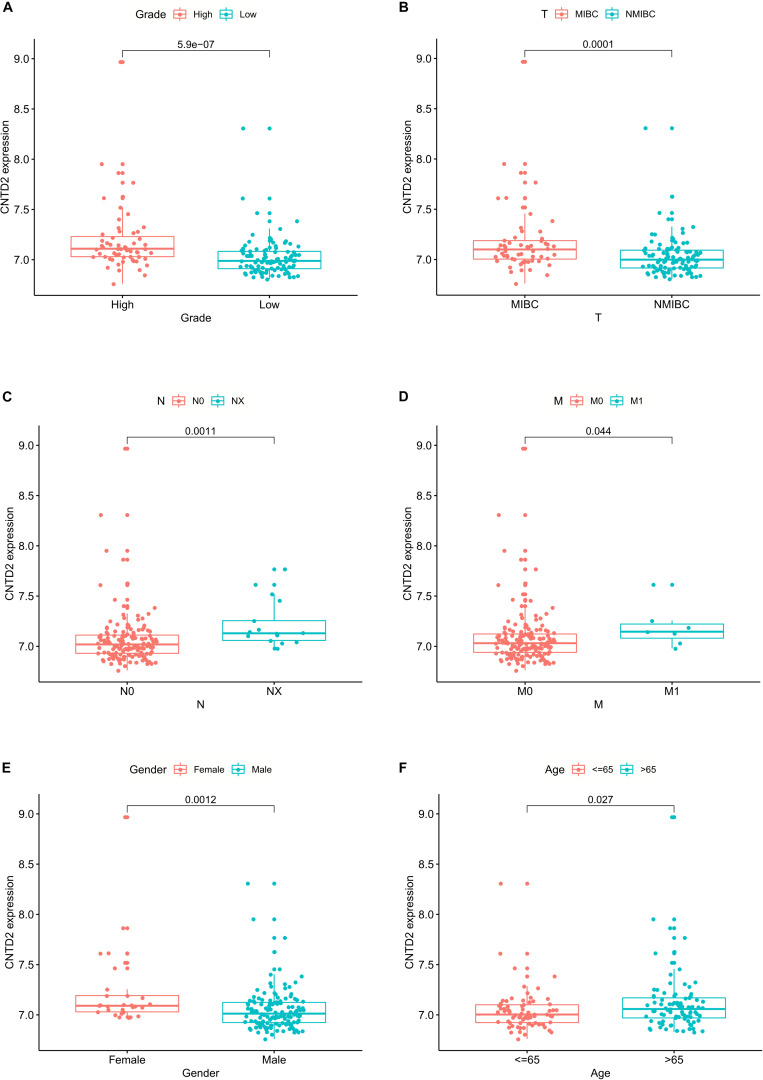
The relationships between CNTD2 expression and clinicopathological parameters in bladder cancer.